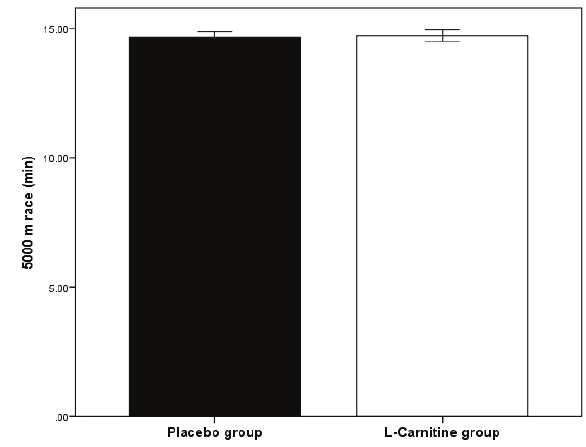
Figure 1. Time of 5000 m race. Mean values ± standard deviation (SD) are shown in the figure. No differences existed between groups (p=0.407). Significance level was set at